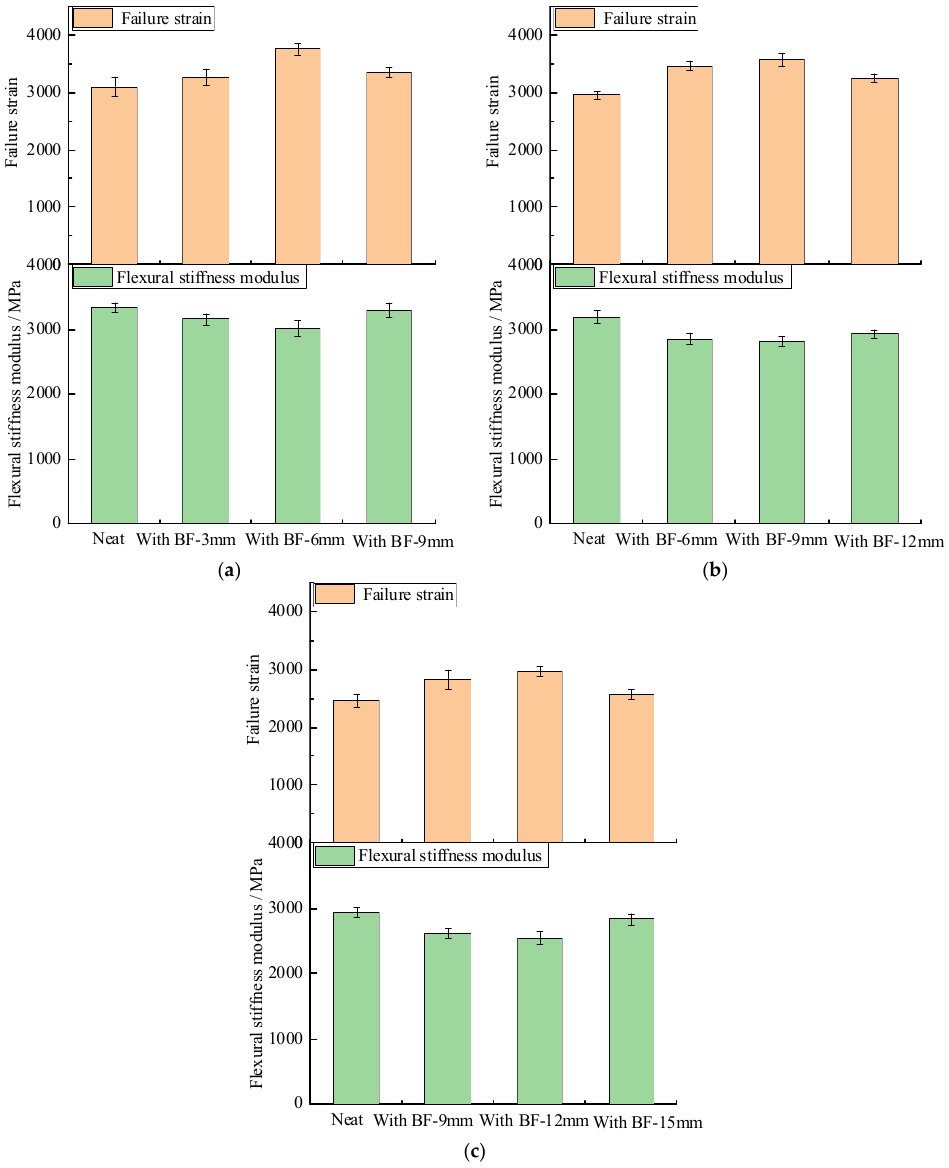
Figure 9. Low temperature bending beam test results: ( a ) SUP-13; ( b ) SUP-20; and ( c ) SUP-25.